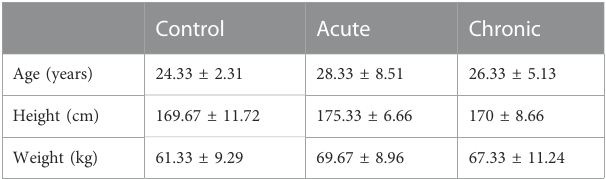
TABLE 4 Demographics data of the participants.